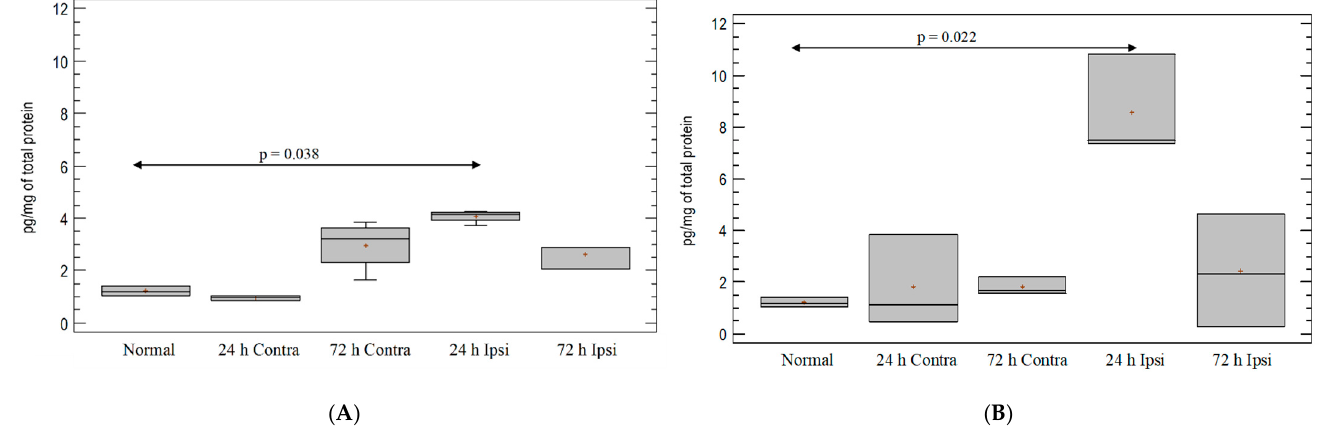
Figure 3. Cytokine IL-1 β expression in mouse brain after ( A ) PBS injection and ( B ) KA injection. Brains were collected 24 h and 72 h postinjection. Ipsi—ipsilateral hemisphere; Contra—contralateral hemisphere; Normal—control animals without any injection.